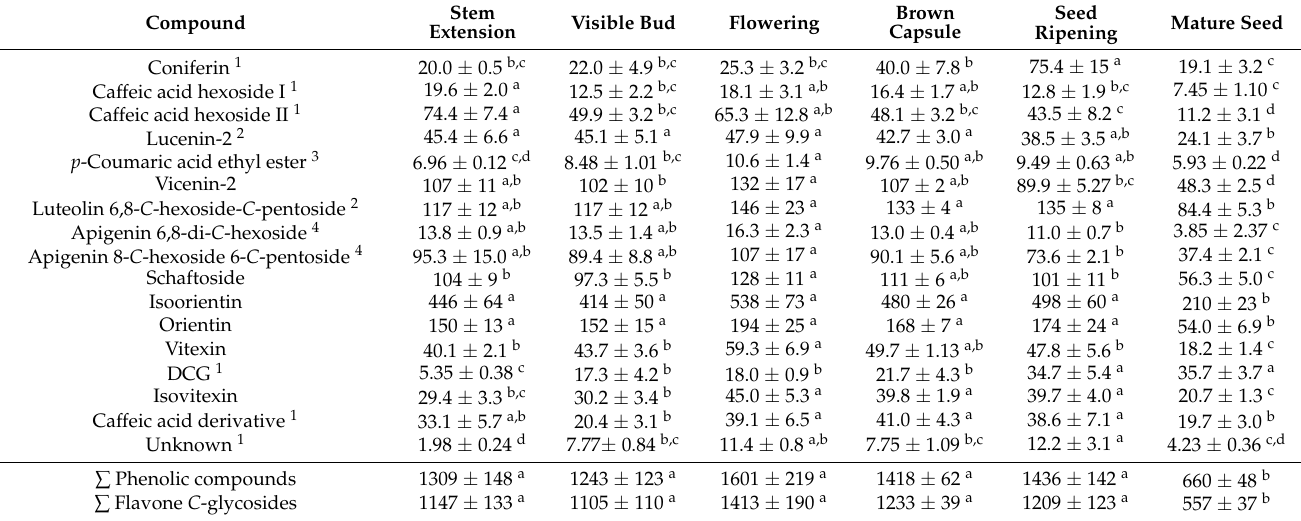
Table 4. Contents of the individual phenolic compounds in the fresh matter (FM) of flax harvested at different growth stages ( µ g/g